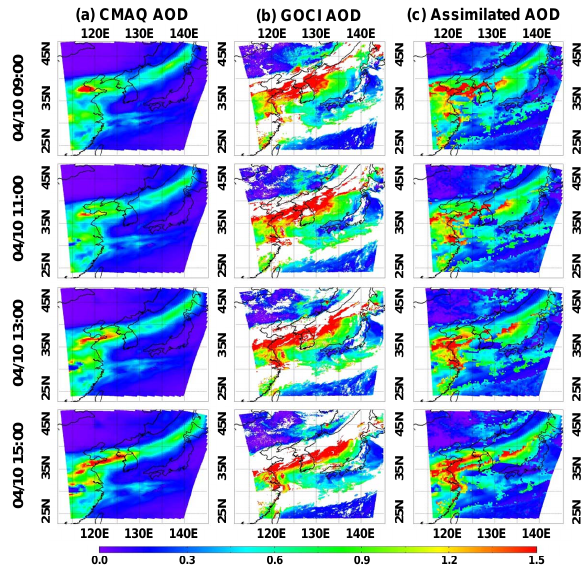
Fig. 6. As Fig. 3, except that the CMAQ-simulated AOD values were calculated via Park et al. (2011)’s conversion